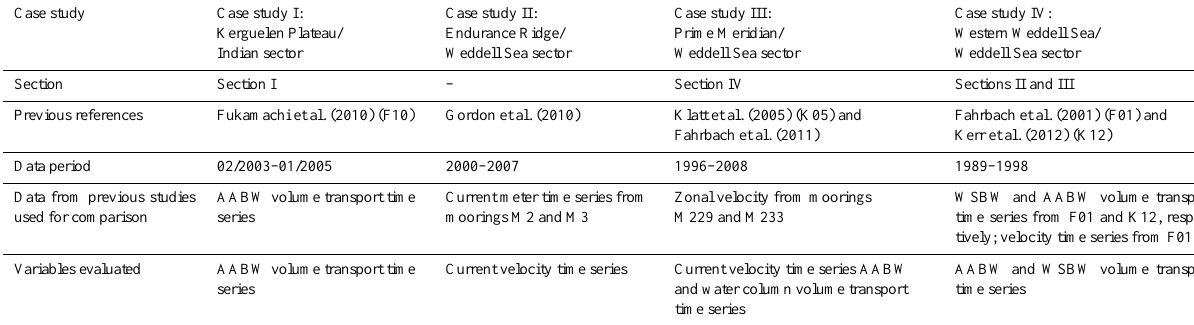
Table 1. Summarized information on the case studies for the velocity and volume transport